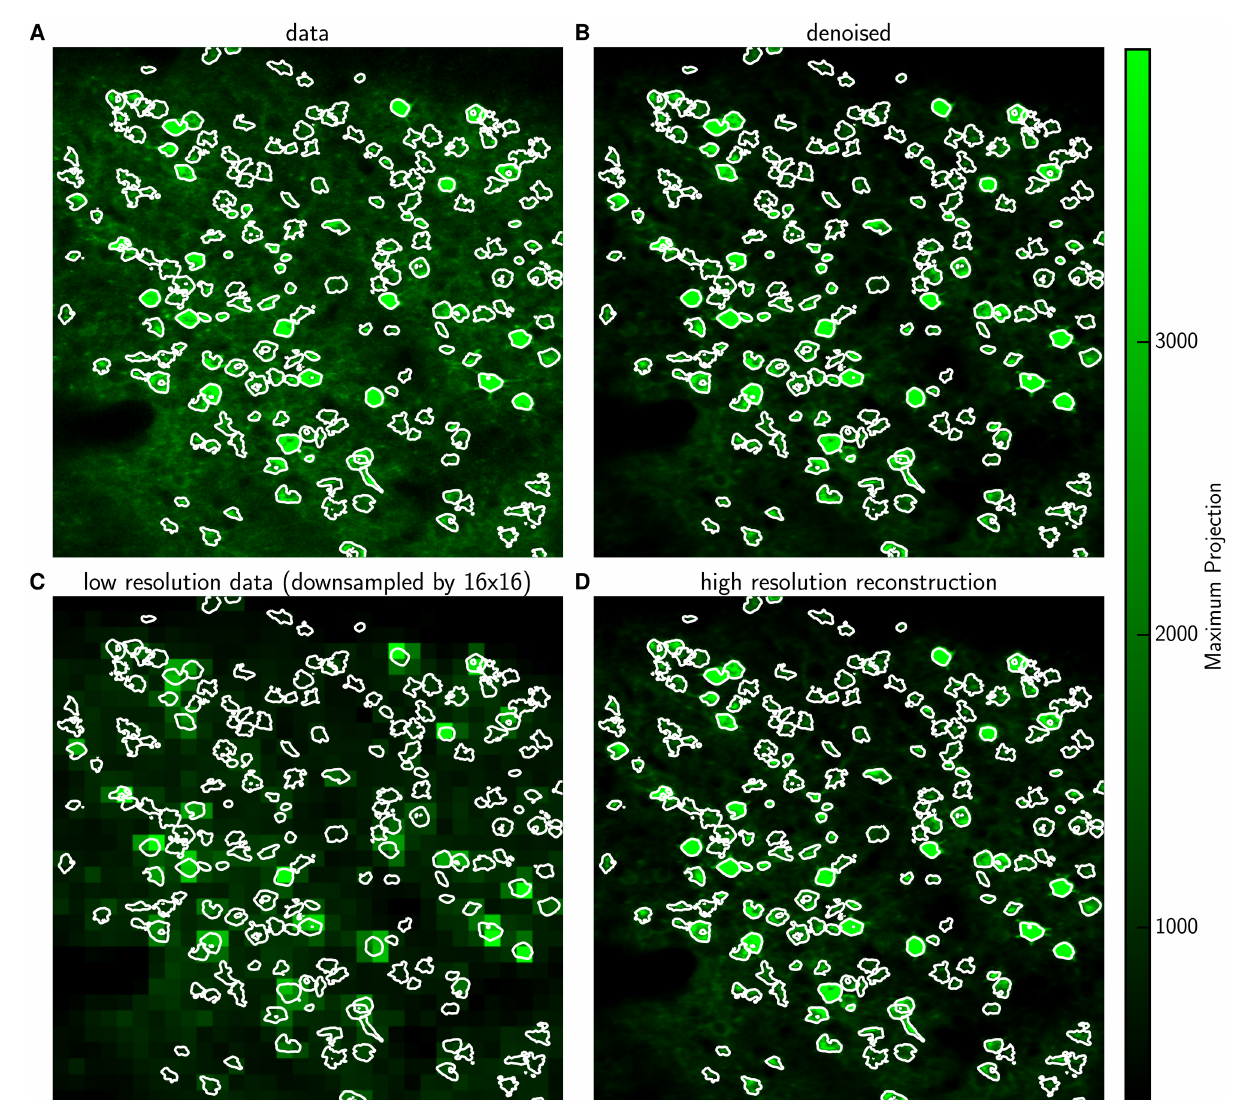
Fig 4. Previously identified shapes allow reconstruction at high spatial resolution based on low resolution imaging (best seen in S2 Video for full details). (A) Max projection image of the raw data Y with identifiedROIs, i.e. neuronsor activity hotspots. Contourlines contain 90% of the energy of each neuralshape. (B) Max projection image of the denoisedestimate A 1 (cid:1) C 1 (plus the estimated background). (C) Max projectionimage for data obtainedat lower spatial resolution, Y l ; l = 16 here. (D) Reconstruction basedon the low resolution data in (C) and previously identifiedshapes, A 1 (cid:1) C l . The reconstruction looks very similar to the denoised high-resolution data of (B). Note: contours in (B-D) are not recomputed in each panel, but rather are copiedfrom (A), to aid